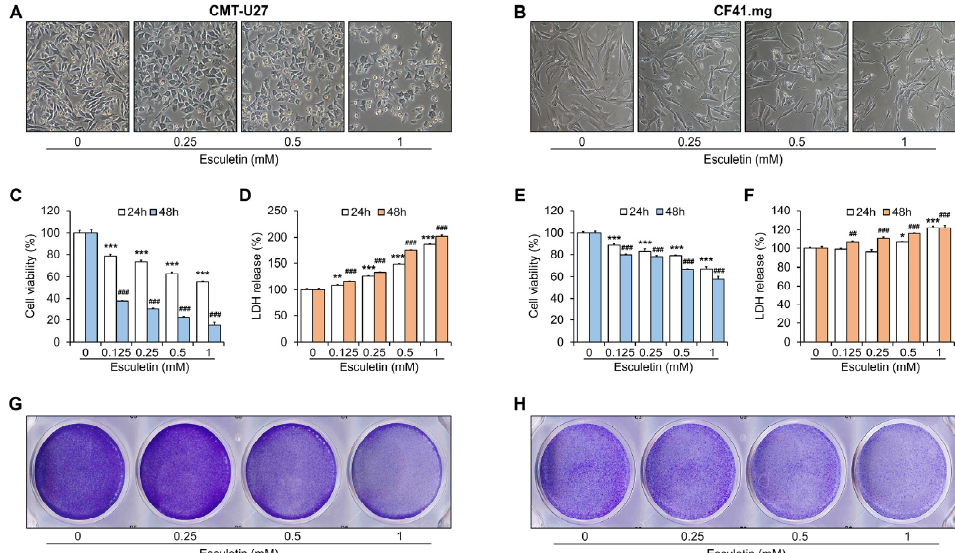
Figure 1. Esculetin inhibits the viability of CMT cells. ( A , B ) Images of morphological changes in CMT-U27 ( A ) and CF41.mg ( B ) cells after esculetin treatment. ( C – F ) Comparisons of the CMT-U27 ( C , D ) and CF41.mg ( E , F ) cell viability and LDH activity. ( G , H ) Images of crystal violet-stained cells in CMT-U27 ( G ) and CF41.mg ( H ) cells after esculetin treatment. Magnification, 100×. Values are mean ± SD. * p < 0.05, ** p < 0.01, *** p < 0.001 versus untreated cells at 24 h; ## p < 0.01, ### p < 0.001 versus untreated cells at 48 h by one-way ANOVA followed by Bonferroni